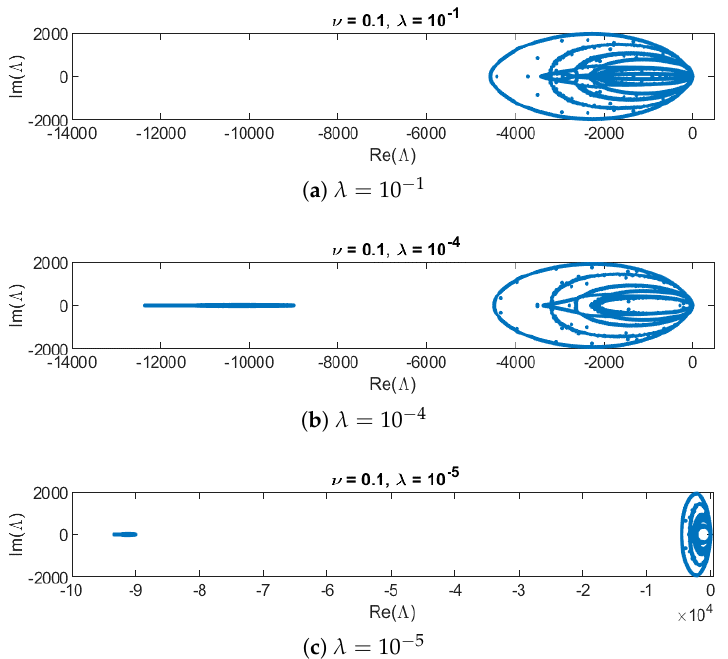
Figure 4. Eigenvalue spectrum, with increasing spectral gap for dam-break case with decreasing λ and fixed N = 2, ν =